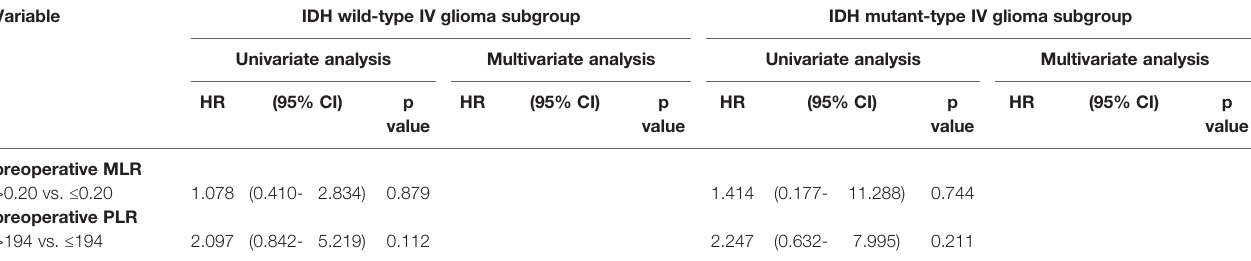
preoperative MLR >0.20 vs. ≤